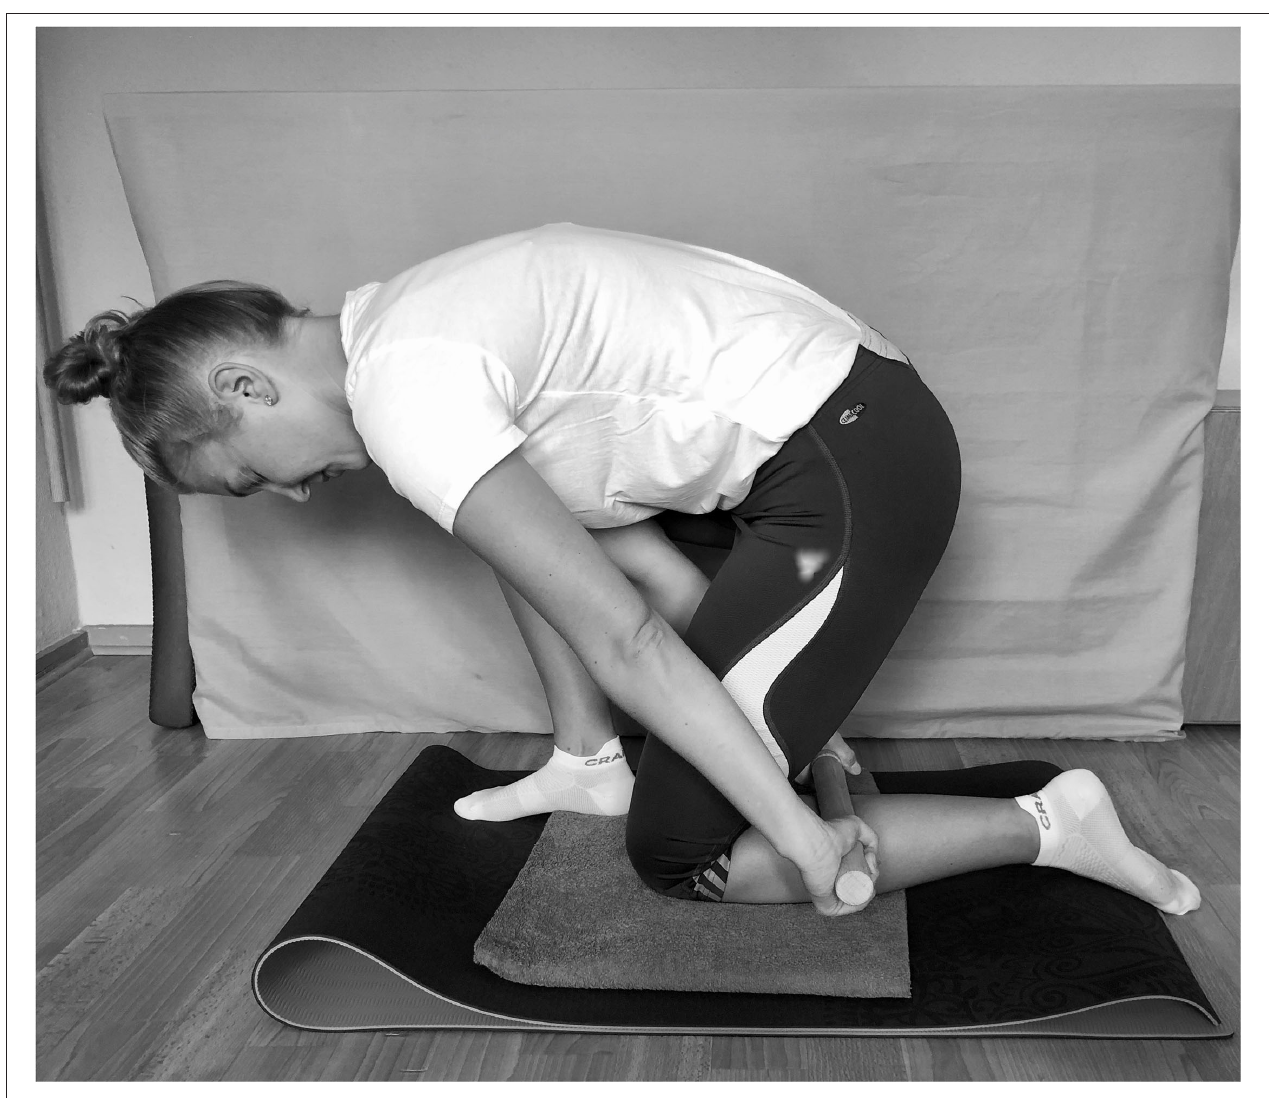
FIGURE 2 | Roller massage